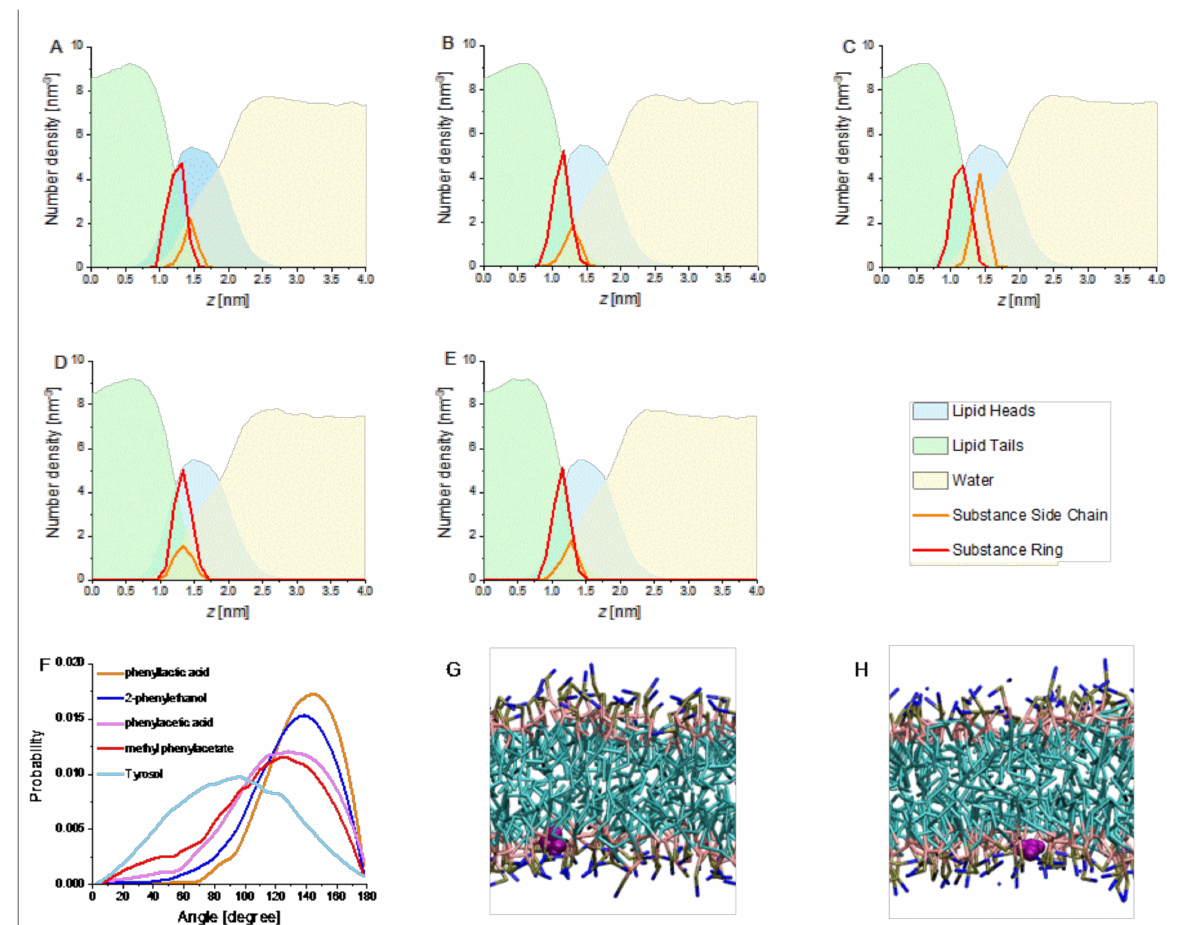
Figure 2. Number–density profiles, compound orientation relative to the membrane normal and simulation snapshots. ( A – E ) The number–density profiles report the molar fraction of different chemical groups in the simulation box, perpendicular to the bilayer. ( A ) 2-PEtOH, ( B ) phenylacetic acid, ( C ) phenyllactic acid, ( D ) Tyrosol, and ( E ) methyl phenylacetate. All substances have shifts between the side chain and ring, except Tyrosol. Molar fractions of the solutes have been multiplied by 50 for clarity. All substances spontaneously insert close to the lipid head groups. ( F ) The angle between membrane normal and compound orientation (defined from side chain to aromatic ring) shows large values for methyl phenylacetate, phenylacetic acid, 2-PEtOH, and phenyllactic acid, indicative of their intercalation in the membrane. Smaller values are reported for Tyrosol, indicating its binding parallel to the membrane surface. ( G , H ) Representative simulation snapshots of 2-PEtOH and Tyrosol (purple) inserted in the headgroup region of the phospholipid membrane. Water is not shown for